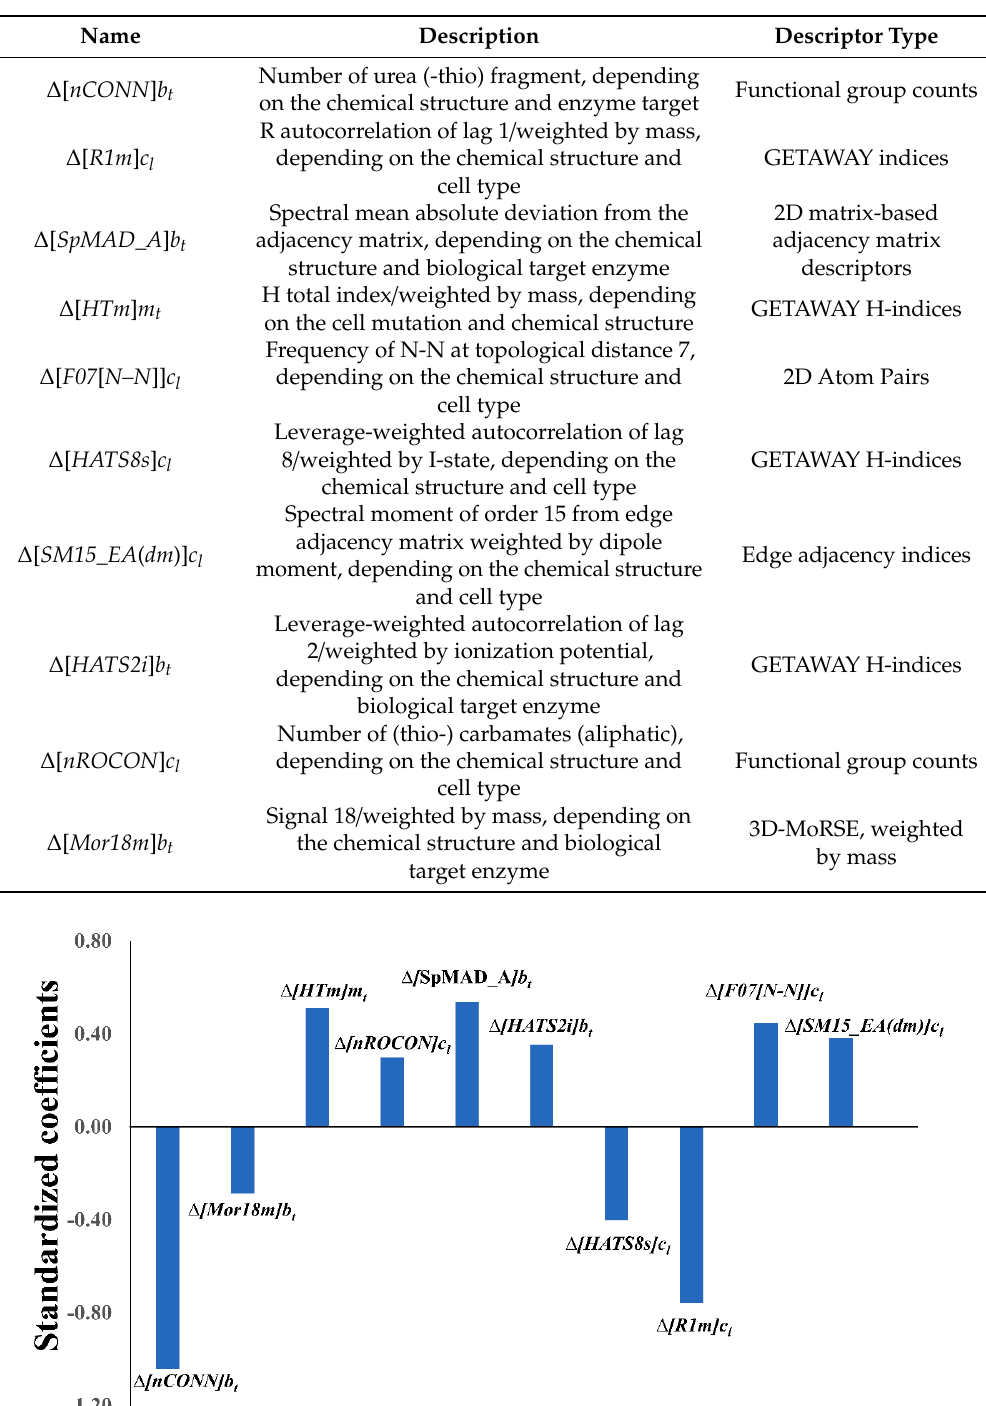
Table 3. Ten variables selected in the multi-target LDA model.